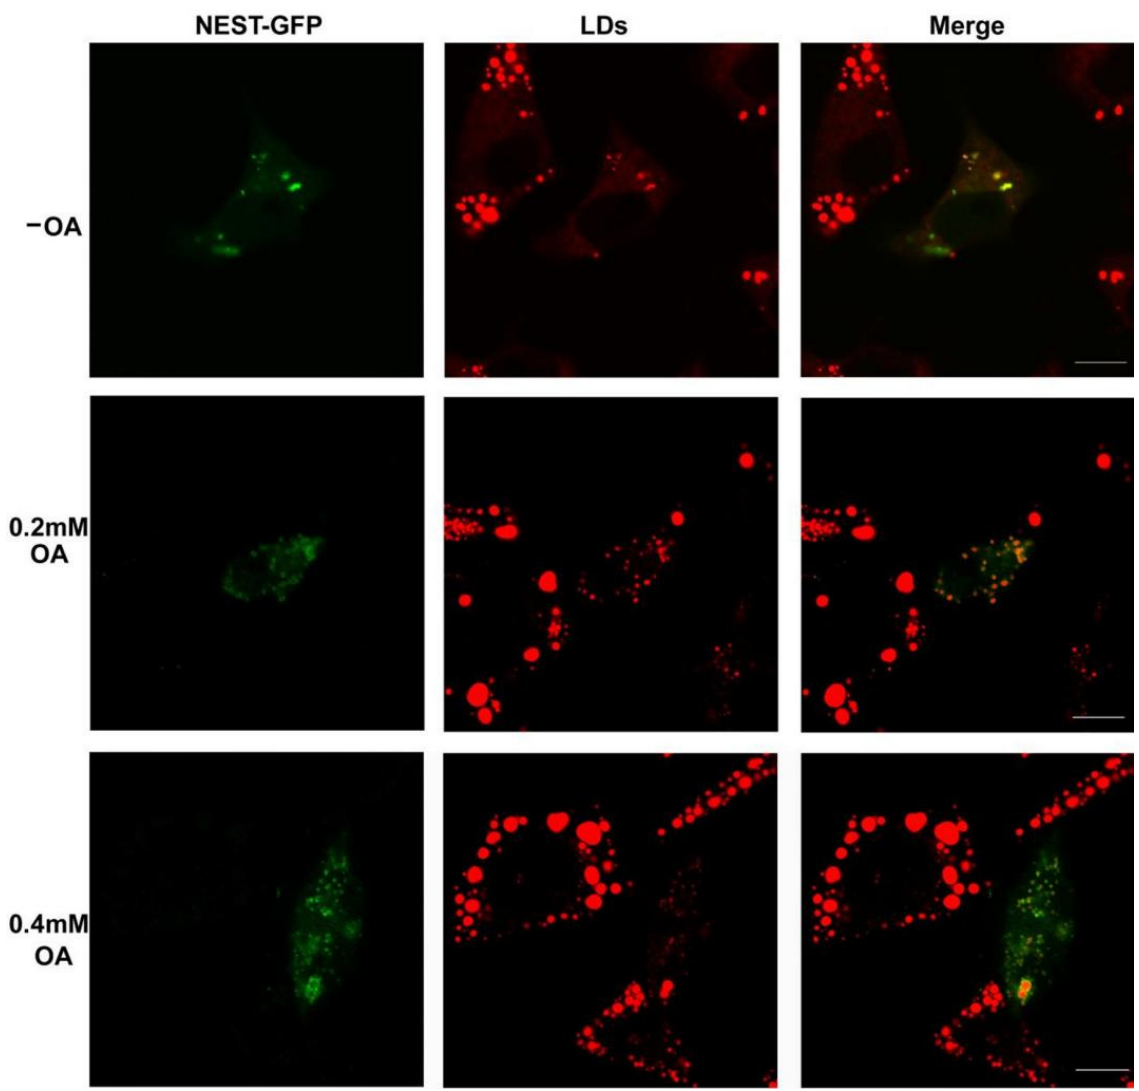
Figure 3. Effect of NEST transient expression on LDs in human neuroblastoma cells. SK-N-SH cells were transfected with NEST-GFP for 24 h, and then incubated with 0.2 mM and 0.4 mM OA for 12 h to induce LD formation or not ( − OA). LDs were stained with HSC LipidTOX TM Deep Red neutral lipid stain before image acquisition by confocal fluorescence microscopy. Figures are representative of at least three experiments. Scale bars, 10 μ m.